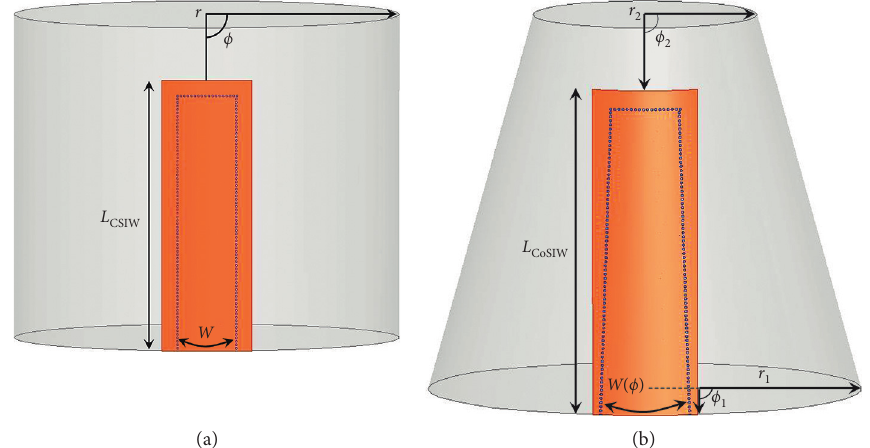
Figure 1: Conformal substrate-integrated waveguide on (a) cylindrical and (b) conical surfaces.